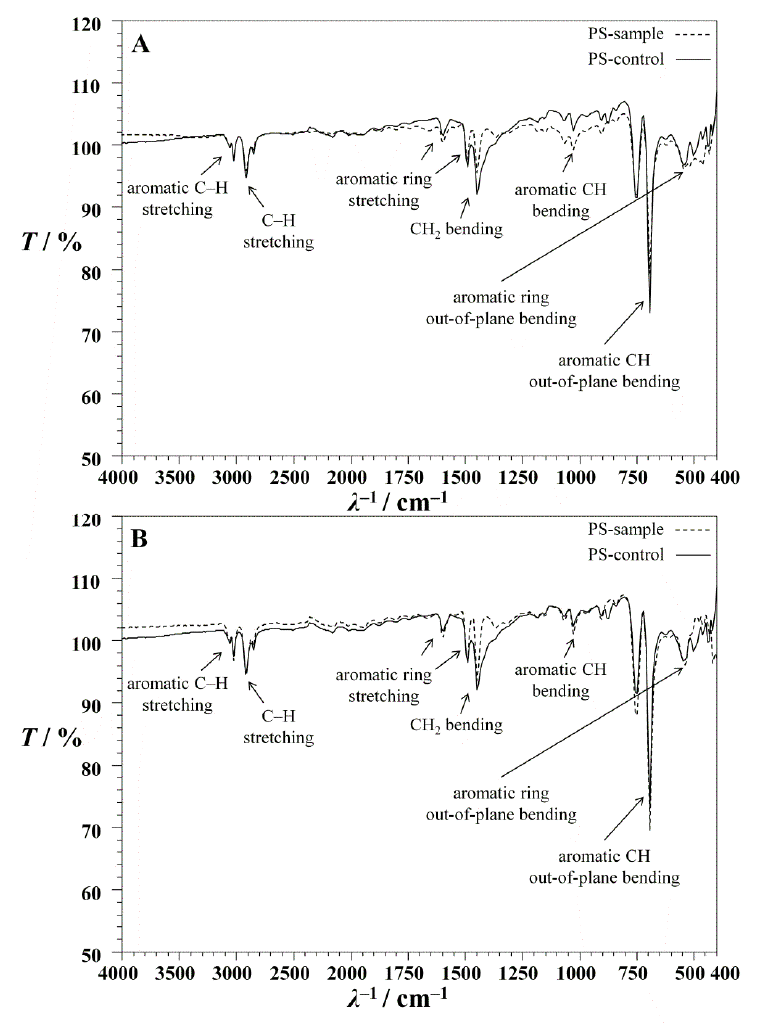
Figure 5. FTIR-ATR spectroscopy of MP-PS particles before (MP-PS control) and after (MP-PS sample) biodegradation by: ( A ) Bacillus cereus in experiment M1-24 and ( B ) Pseudomonas alcaligenes in experiment M2-23.